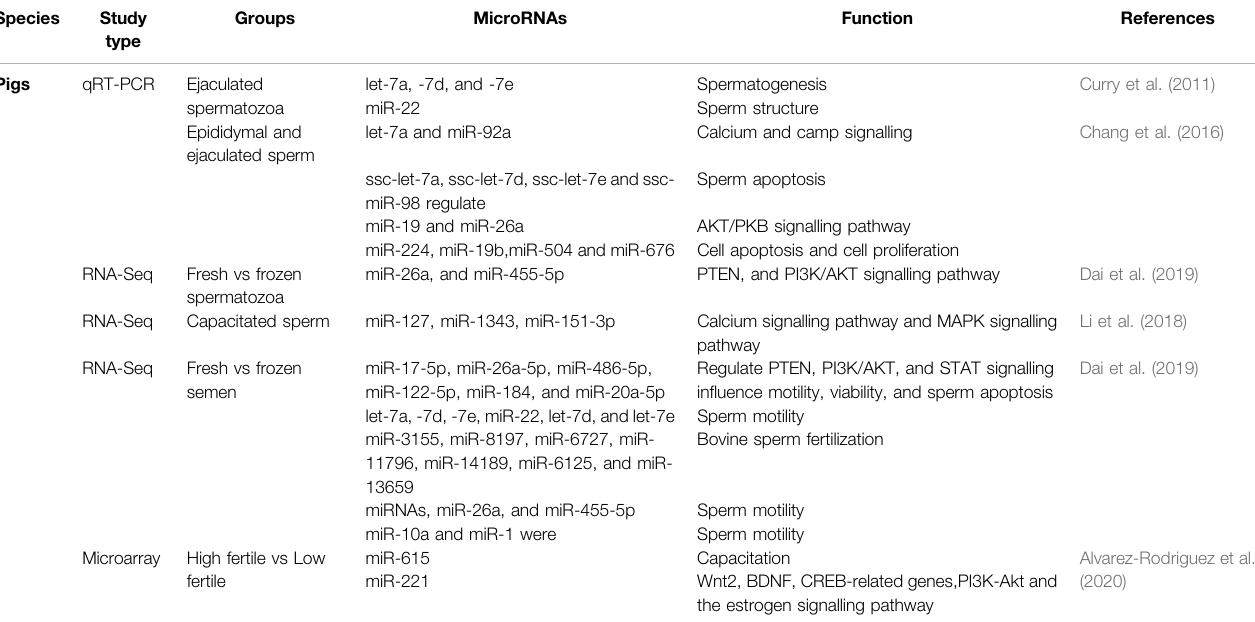
TABLE 4 | Important non-coding microRNAs reported in pig spermatozoa by transcriptome analysis.